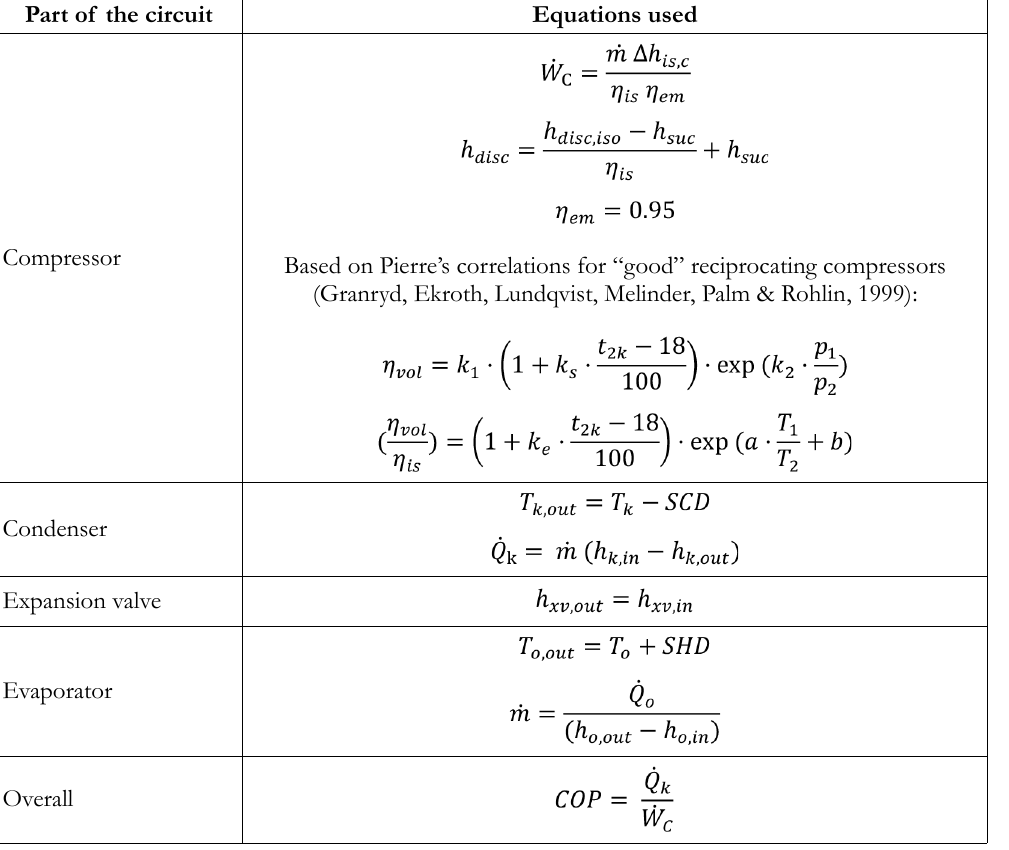
Table 1. Equations used for modelling the HTHP operation